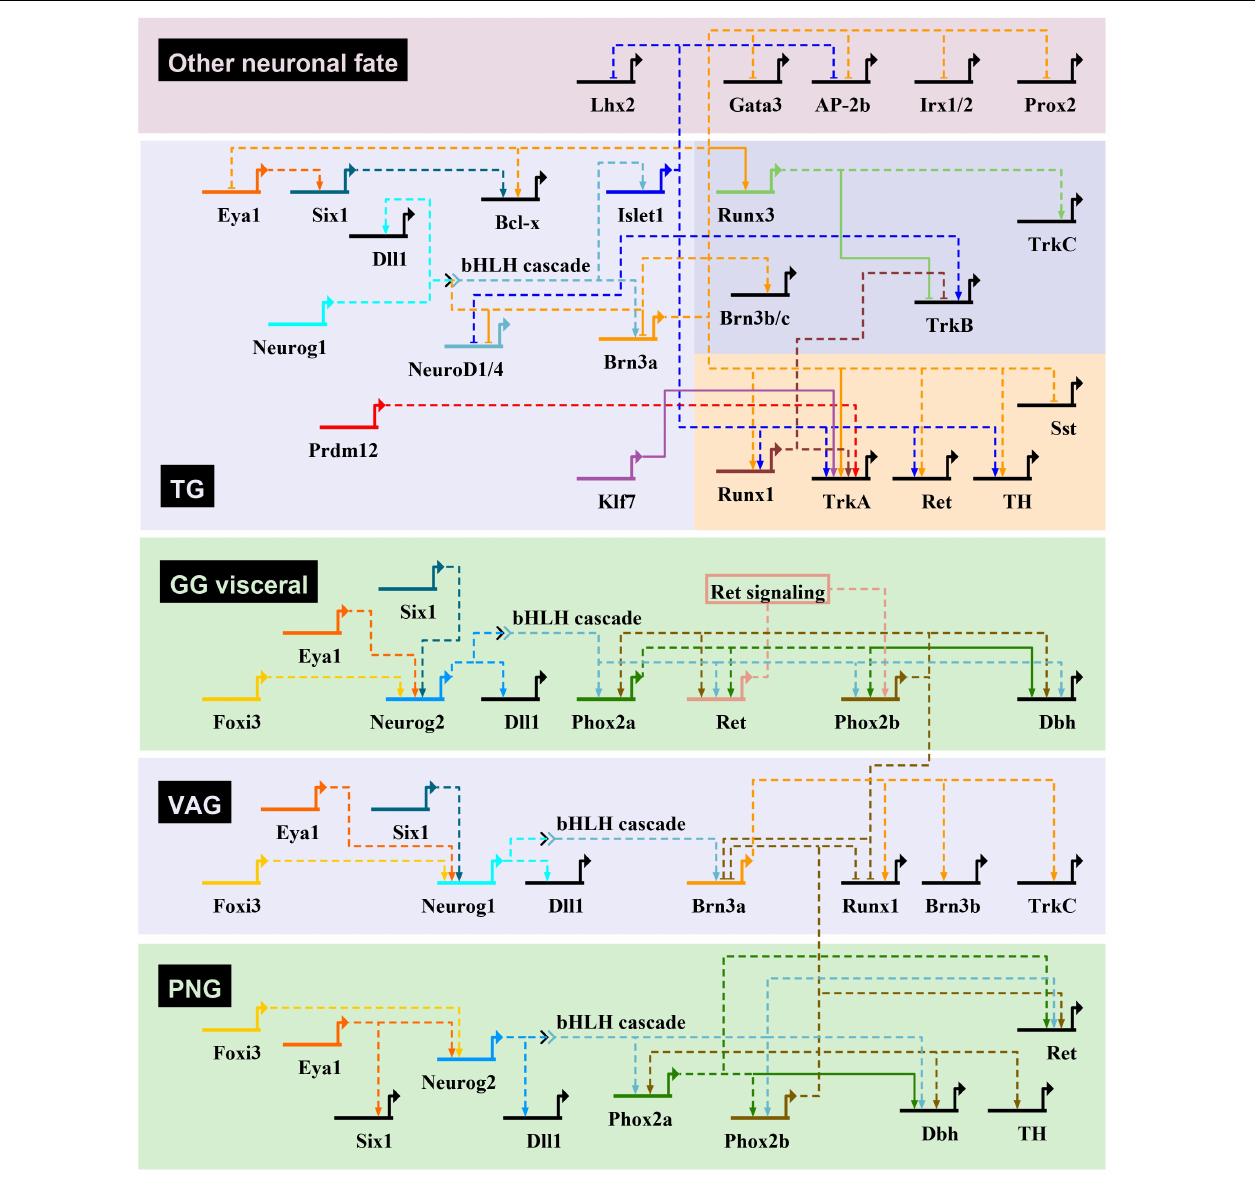
FIGURE 4 | Transcriptional regulatory networks controlling neurogenesis in mouse cranial sensory ganglia. Gene regulatory interactions for the initiation of sensory neuron transcriptional programs in cranial ganglia through bHLH TF gene activation. The gene regulatory networks have been drawn using BioTapestry (Longabaugh et al., 2005), with transcriptional activation indicated by arrows, and repression by blunt-ended arrows. For the geniculate ganglia (GG), only the genes involved in VSN development are represented. In trigeminal ganglia (TG), genes specific of the mechanosensory and nociceptive lineages are shown on a darkblue and red background, respectively. Dashed lines are drawn if there is no evidence for direct regulation of target gene. The proposed gene regulatory network is based mostly from observations made in cranial ganglia from different mutant mouse lines, that have been characterized in the following references (see text for